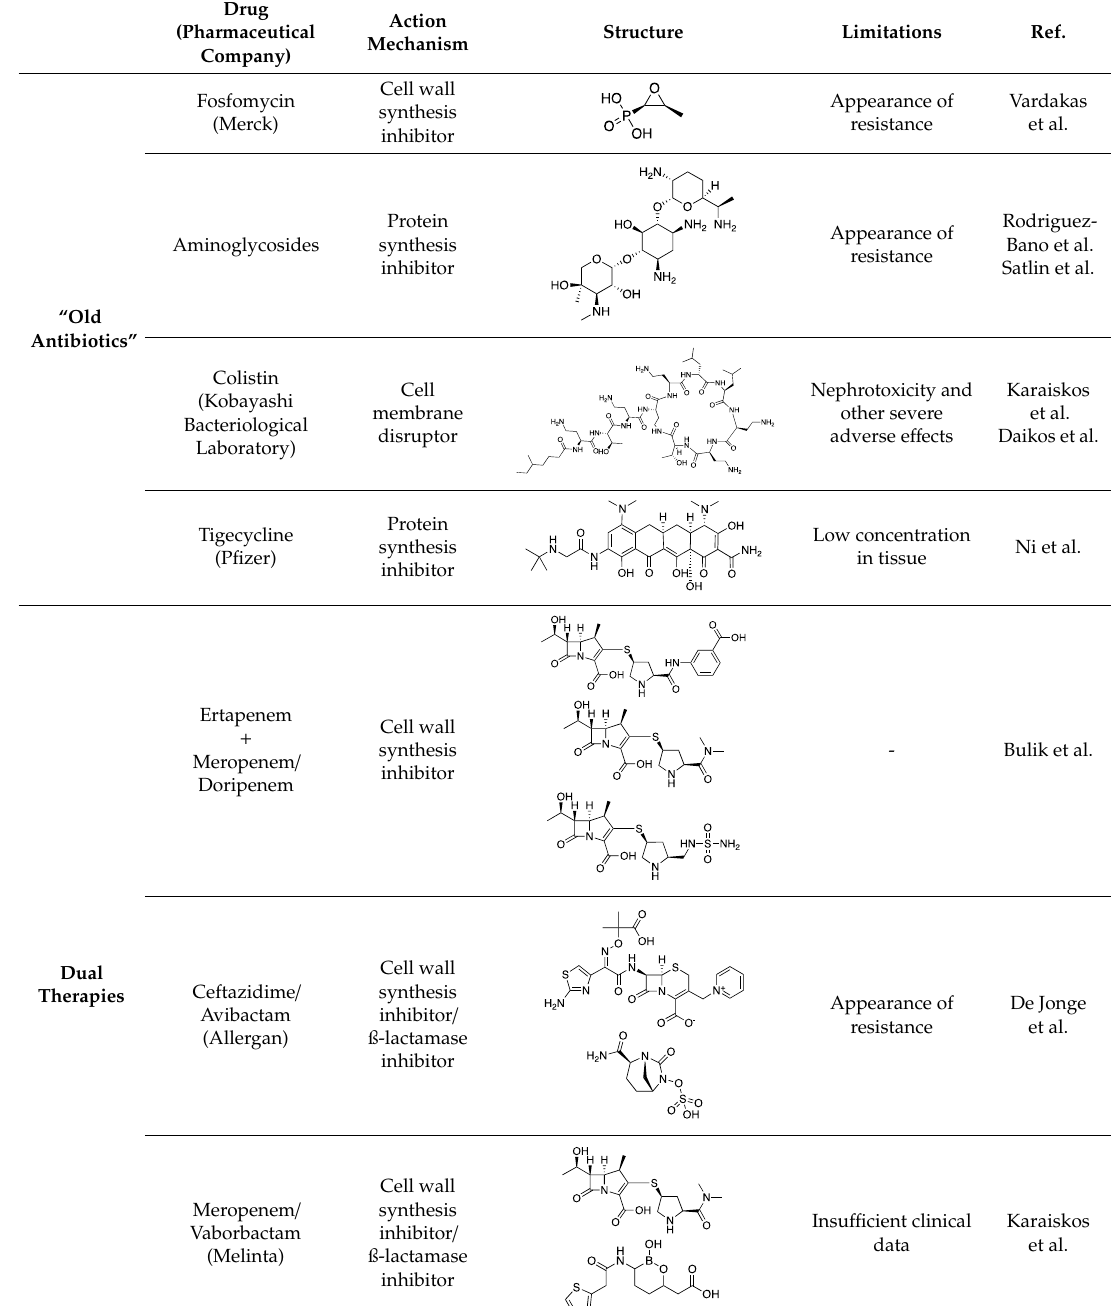
Table 3. Current and future treatment options for infections caused by CRE.